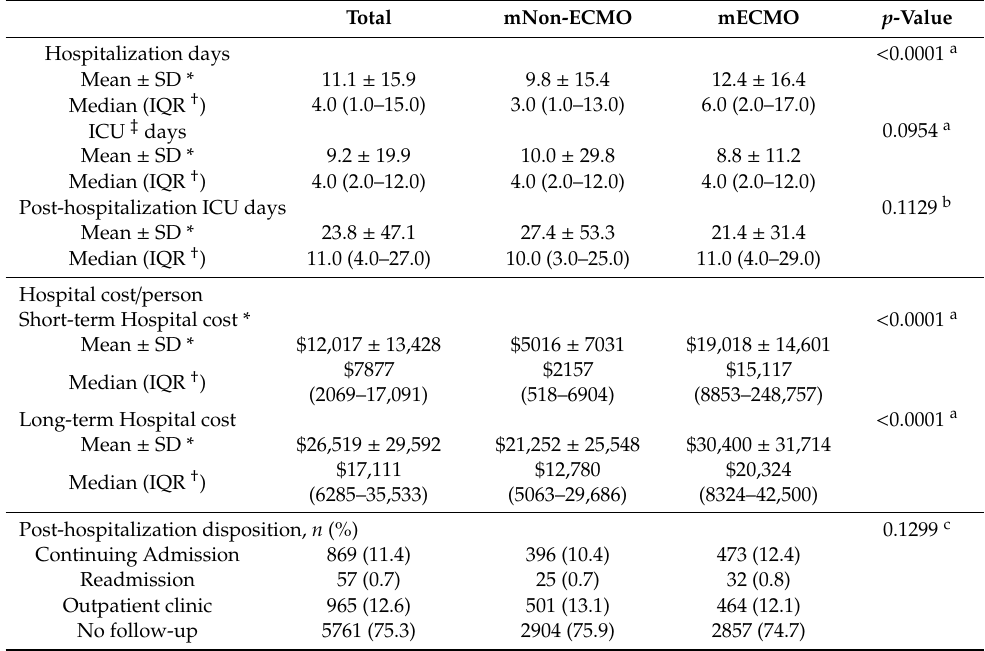
Table 5. Comparison of hospitalization days, hospital costs, and disposition in both groups after propensity matched